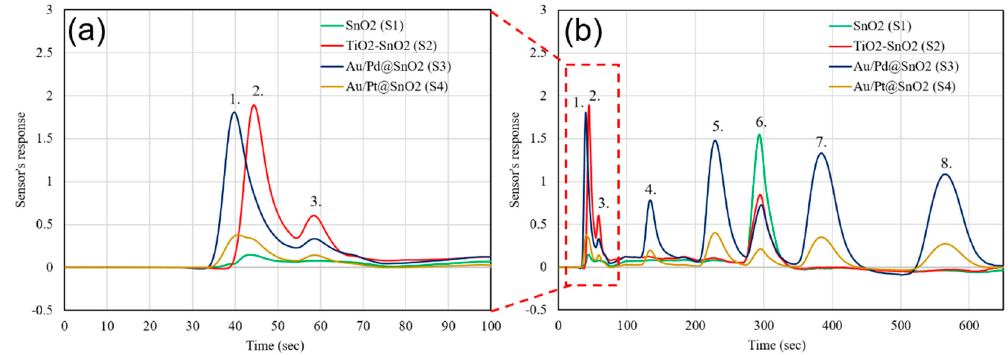
Figure 6. Gas chromatogram of Mix. 2: ( a ) Zoomed image of light compounds and ( b ) the full gas chromatogram. (1. Methane 99.99%, 2. H 2 S 100 ppb, 3. Ethyl-Mercaptan 50 ppb, 4. Benzene 10 ppb, 5. Toluene 10 ppb, 6. Water, 7. Ethylbenzene 10 ppb, 8. O-Xylene 10 ppb). Table 2. Gas mixtures and concentrations.